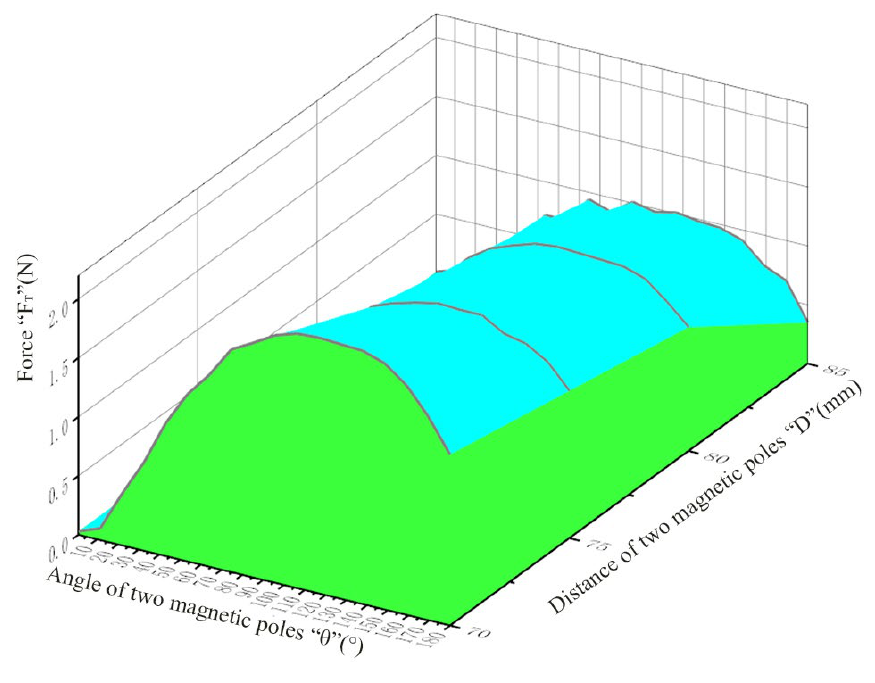
Figure 5. Forces at different D and θ .